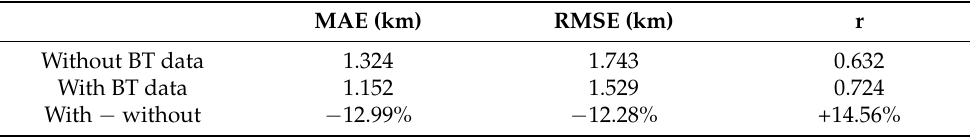
Table 11. Comparison of algorithm results with and without BT